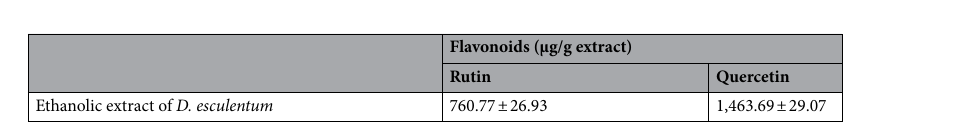
Table 3. Quantification of rutin and quercetin in the ethanolic extract of D. esculentum